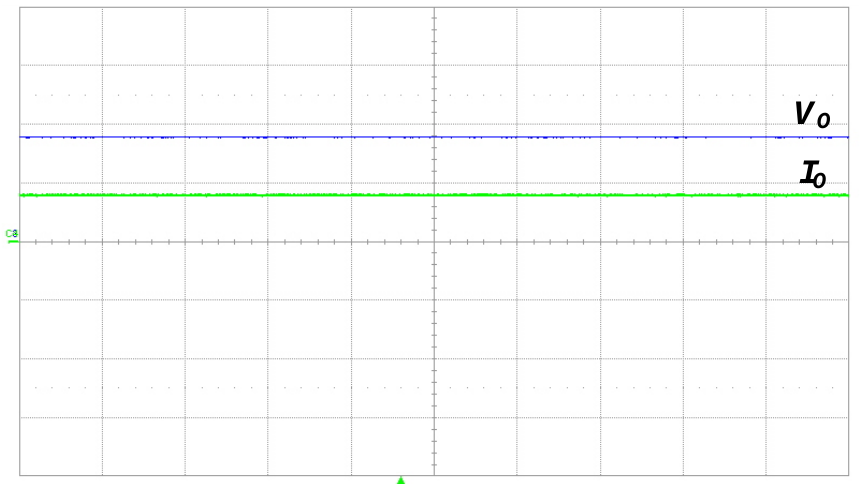
/ div) and current I / div); time scale: 5ms / O (5 A